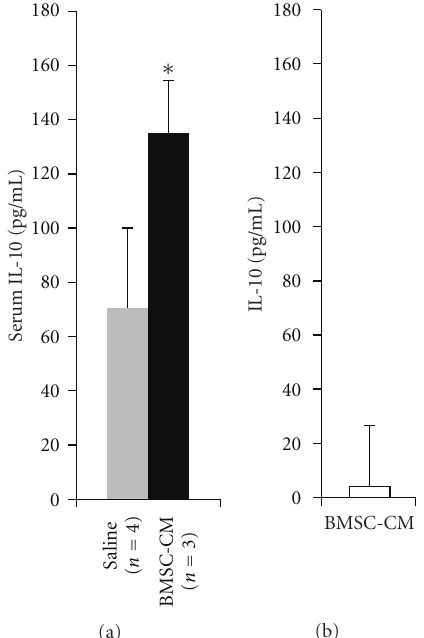
Figure 6: BMSC-CM significantly upregulates IL-10 in AKI rats, and BMSC-CM is not an exogenous source of IL-10 . (a) Rat serum IL-10 was measured via ELISA from rats administered a lethal dose of cisplatin (7.5mg/kg) and then treated with either vehicle or BMSC-CM at 3, 9, 24, 48, and 72 hours after cisplatin administration. Blood was collected via tail snip, and the serum was analyzed on day 3. ∗ P < 0 . 05 by Student’s t -test. (b) IL-10 was measured via ELISA in whole